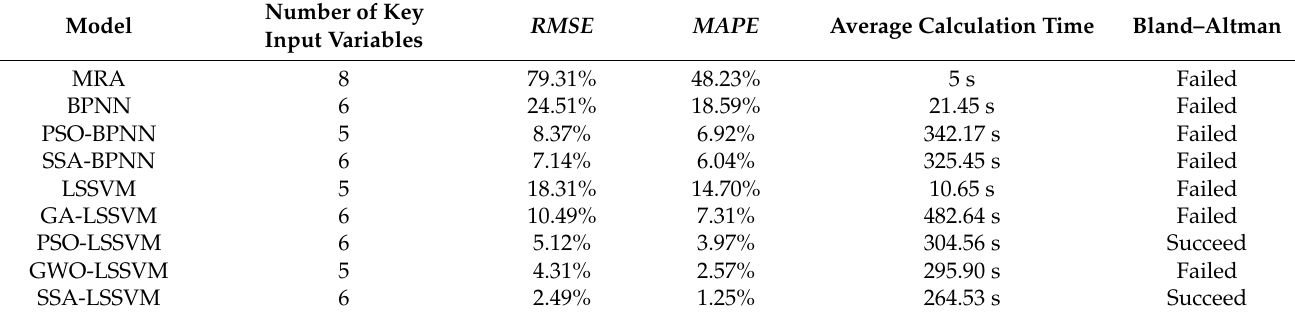
Table 14. Calculation results of different